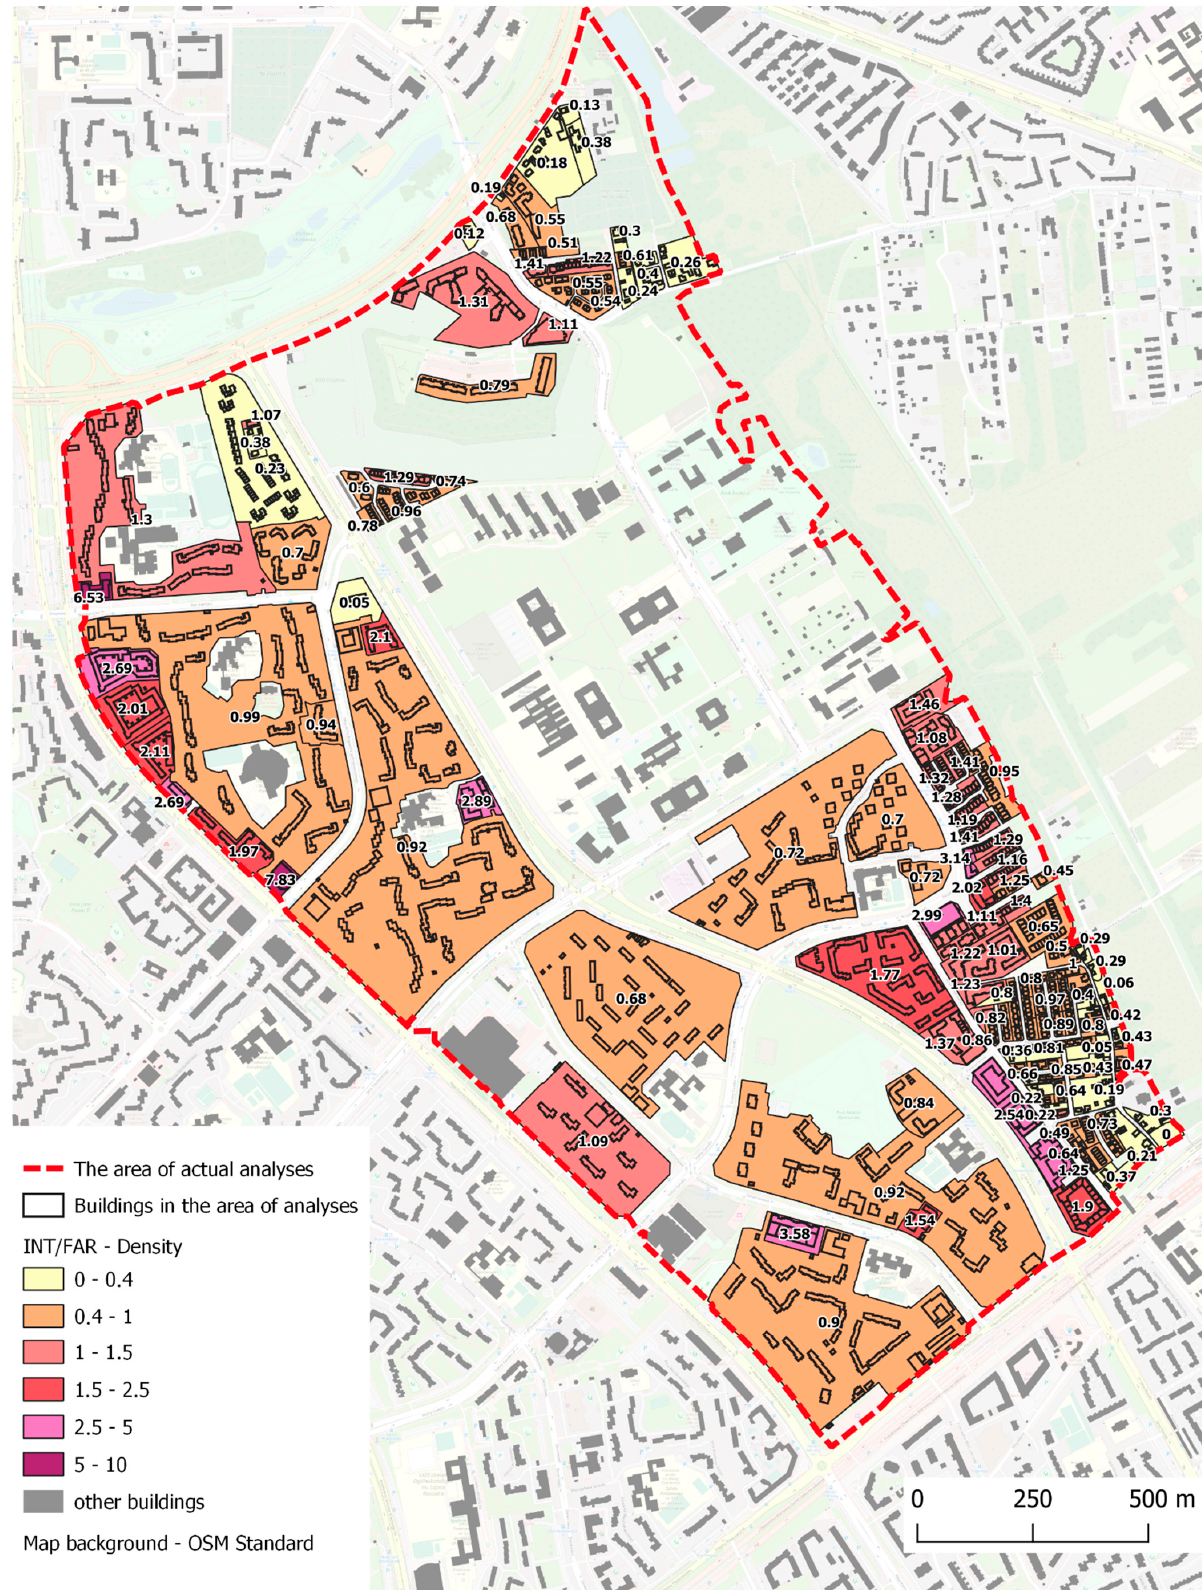
Figure A2. Density-INT. Figure A2.